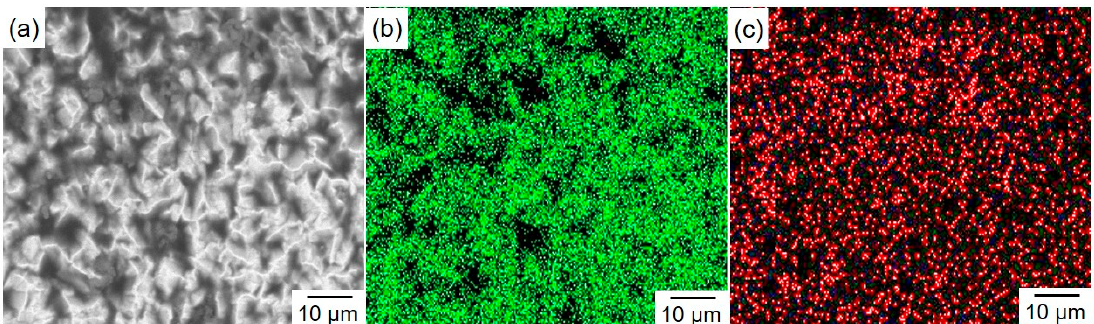
Figure 6. FE-SEM image of an electrodeposited Sn-15 at.%Zn alloy film ( a ). EDX elemental mapping images of Sn and Zn are also shown in ( b ) and ( c ), respectively.